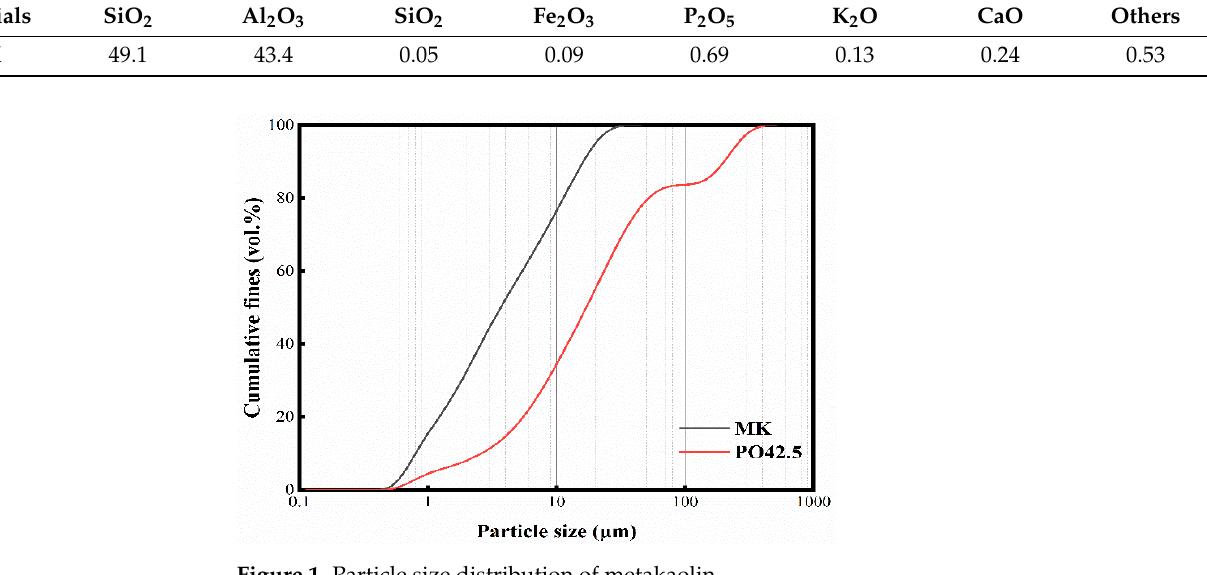
Figure 1. Particle size distribution of metakaolin. Table 2. Particle size distribution (PSD) of metakaolinite.